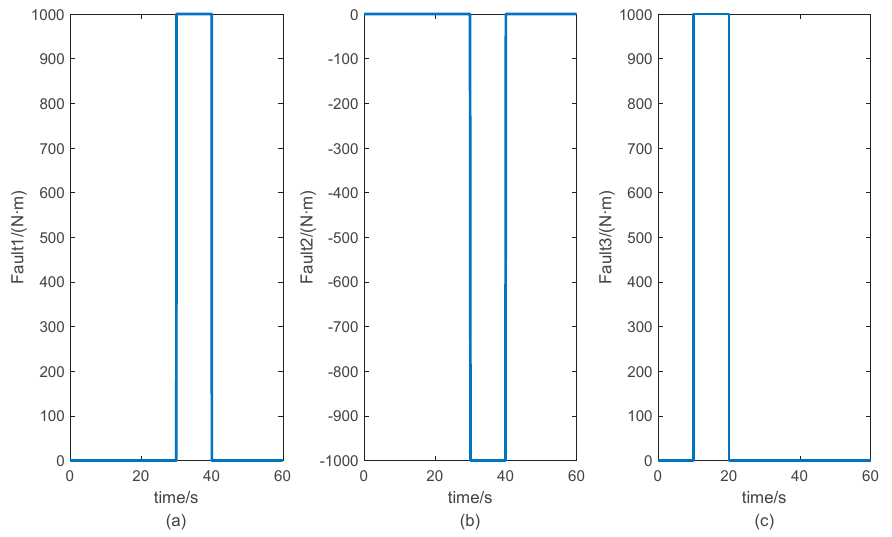
Figure 6. Curves of the faults. ( a ) Curve of fault of Agent 1. ( b ) Curve of fault of Agent 2. ( c ) Curve of fault of Agent 3.